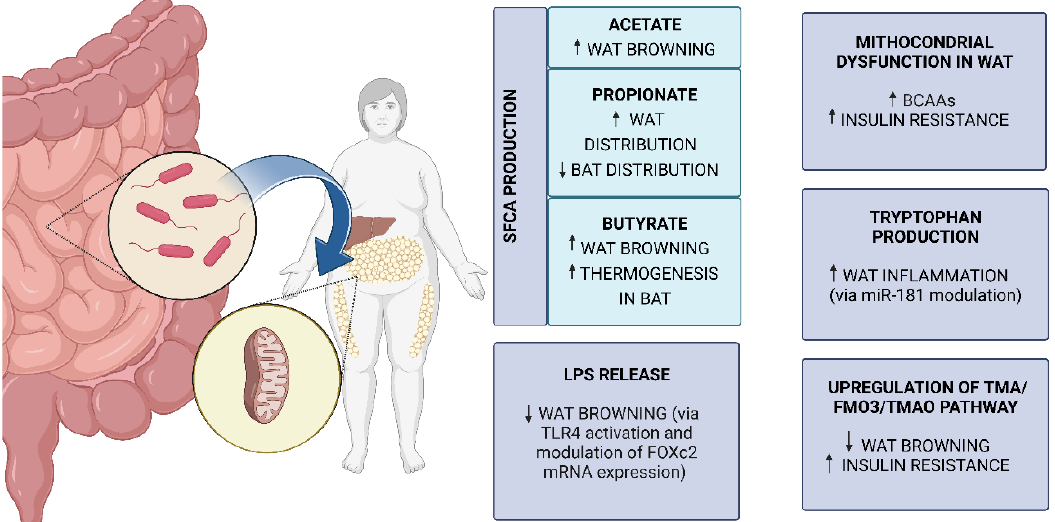
Figure 3. Gut microbiota and microbial metabolites’ influence on WAT mitochondria in obesity. The interplay between gut microbiota and WAT mitochondria is mediated by microbial metabolites such as SCFAs, LPS, BCAAs, tryptophan, and trimethylamine. Among these, SCFAs are the most studied. Created with BioRender.com (accessed on 13 March